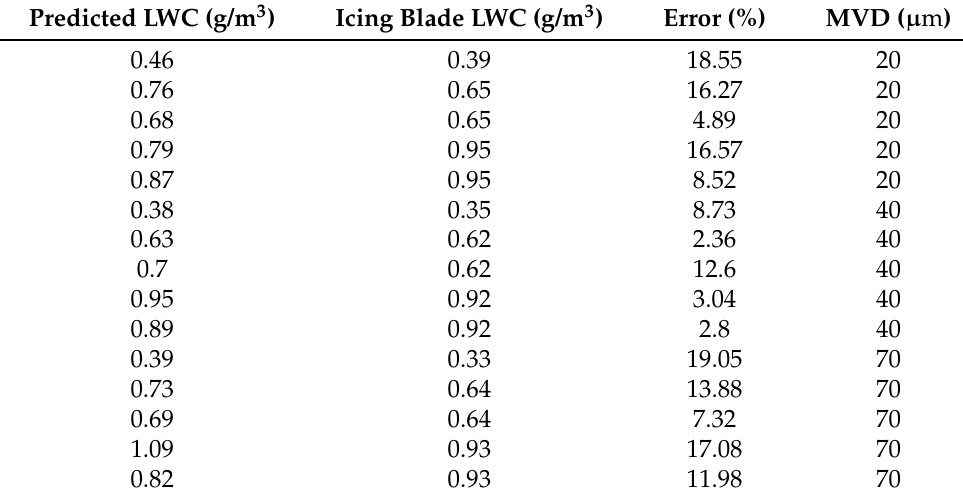
Table 5. Icing blade and predicted LWC comparison.